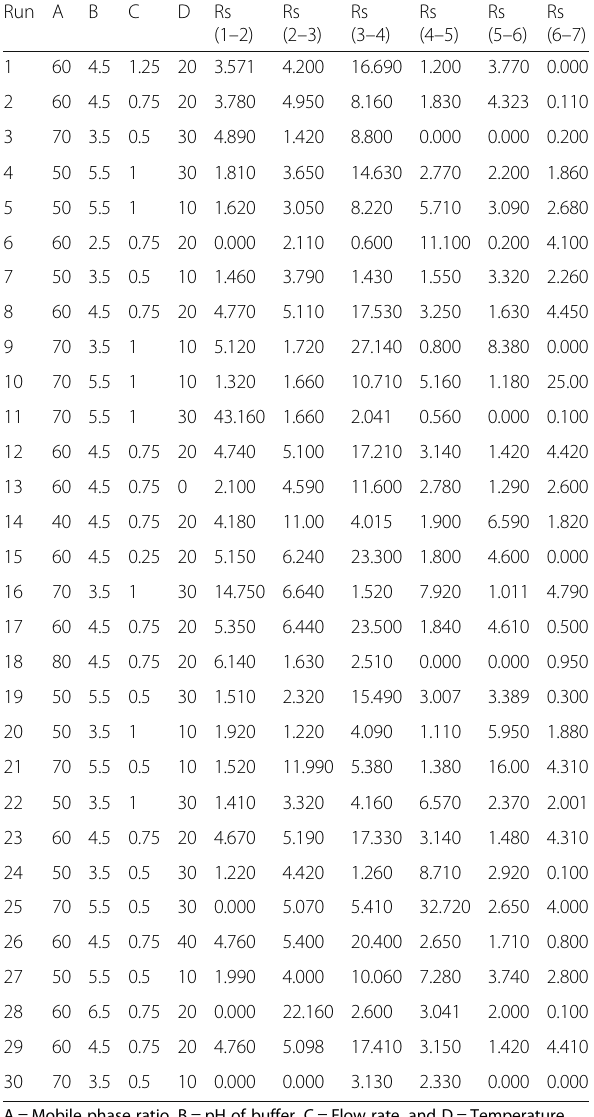
Table 2 Optimization by central composite